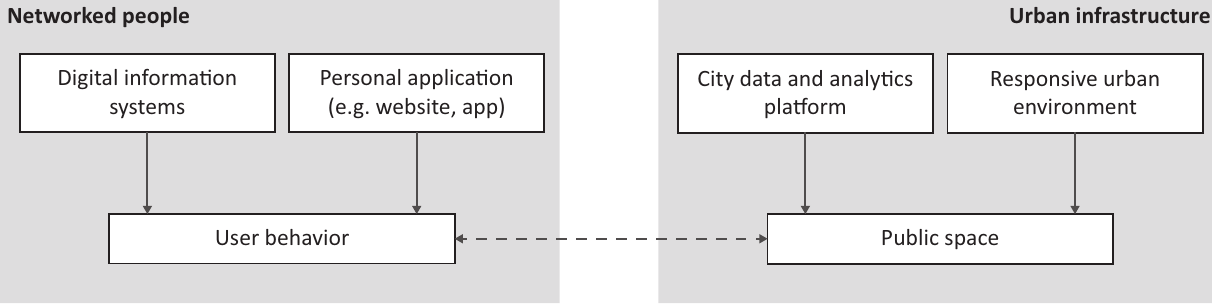
Figure 1. Identified algorithmic mediators in the urban context, and their impact on user behavior and the public